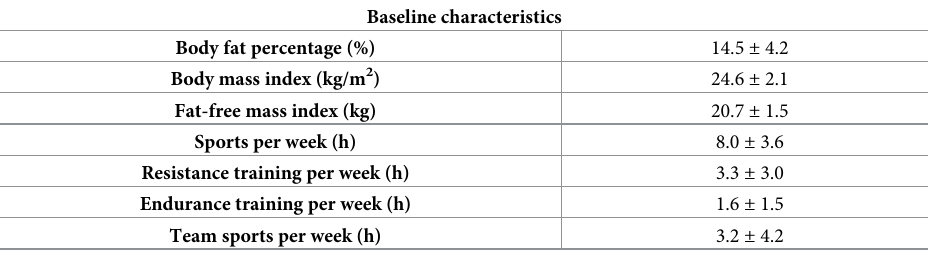
Table 1. Baseline characteristics of the study population.